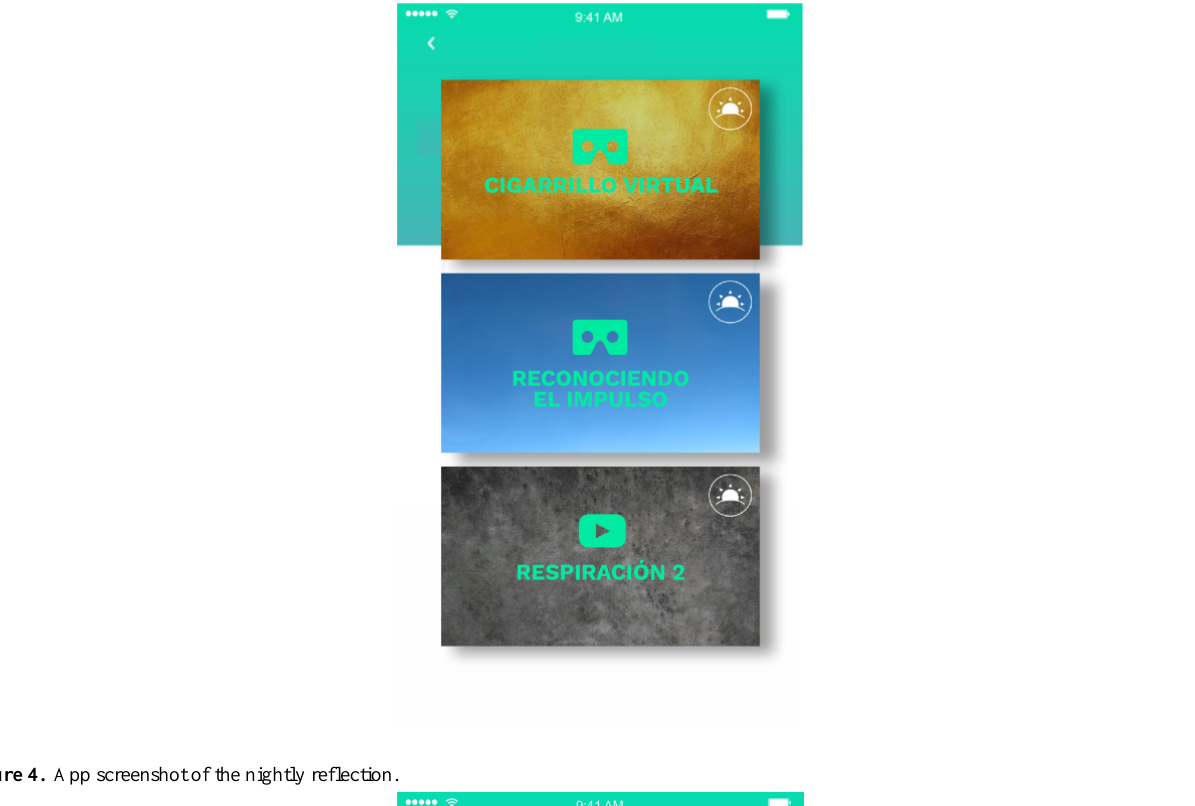
Figure 3. App screenshot of the home screen showing mindfulness activities.